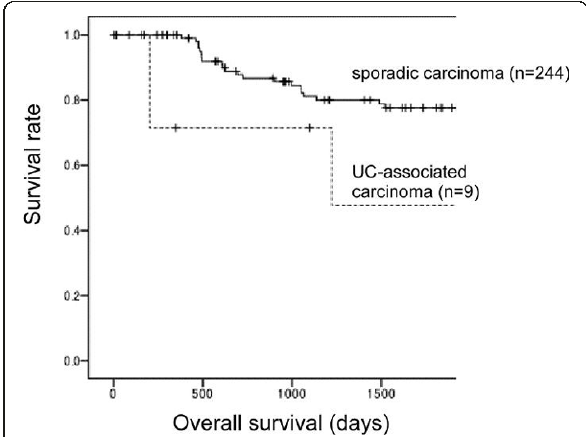
Figure 1 Prognoses were analyzed for cases of ulcerative colitis (UC)associated and sporadic colon carcinomas of stages 2 and 3 . For all cases, UC-associated carcinoma showed worse overall survival than sporadic carcinoma ( P = 0.010). When cases were limited to well differentiated carcinomas, no significant difference was shown ( P = 0.136). Similarly, the cases limited to moderately to poorly differentiated ones, no significant difference was shown ( P =